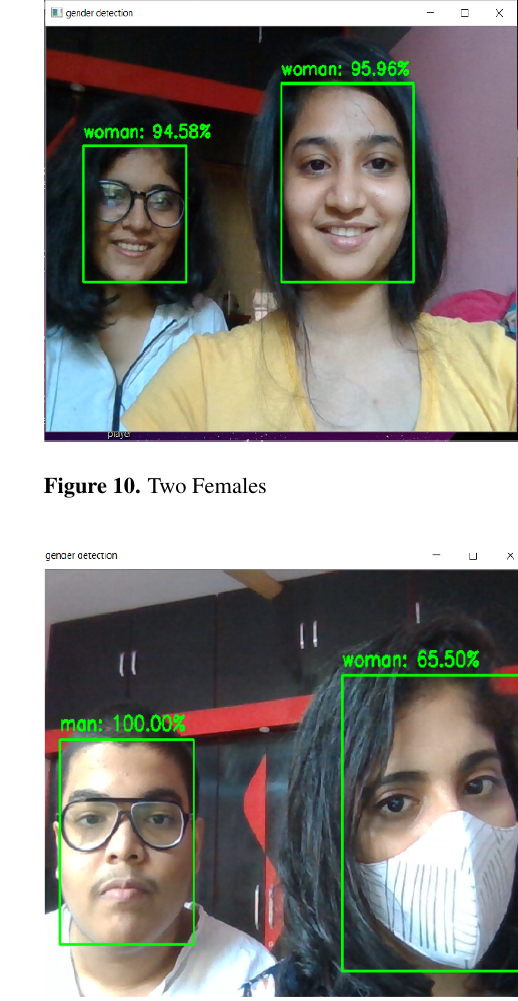
Figure 11. Unmasked and Masked